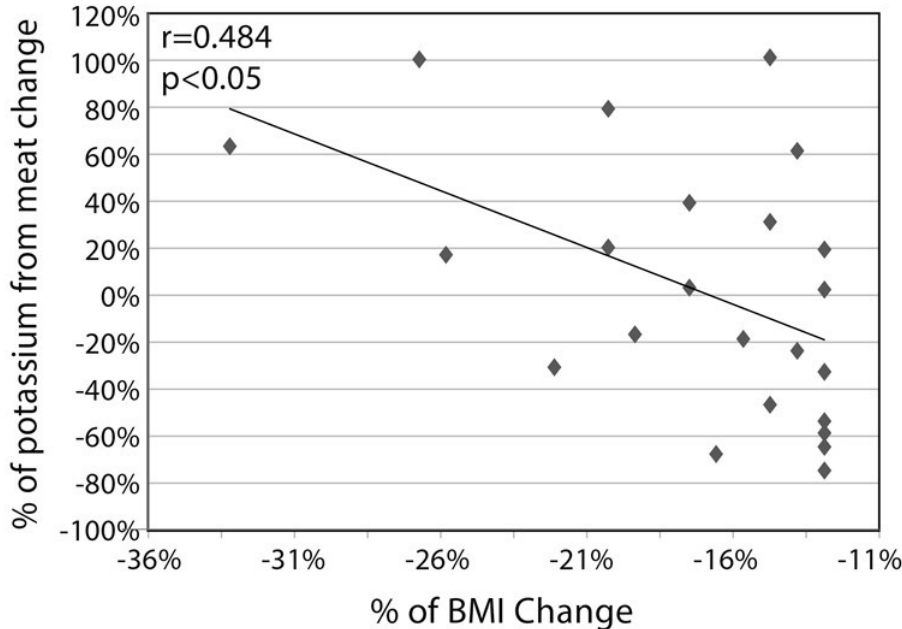
Figure 4. Correlation between the % change in potassium intake from meat products (mostly poultry) and % change in BMI in subjects whose achieved decrease in BMI was above the average ( n = 23), after 1 year of intervention p = 0.019.